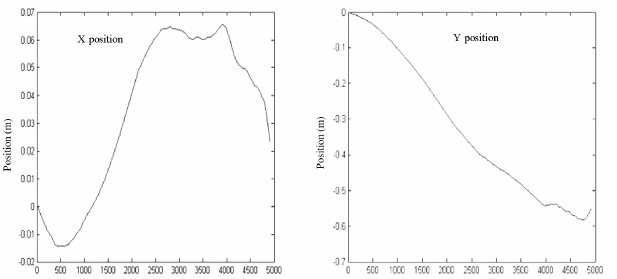
Figure 7. Trajectory estimation for movement